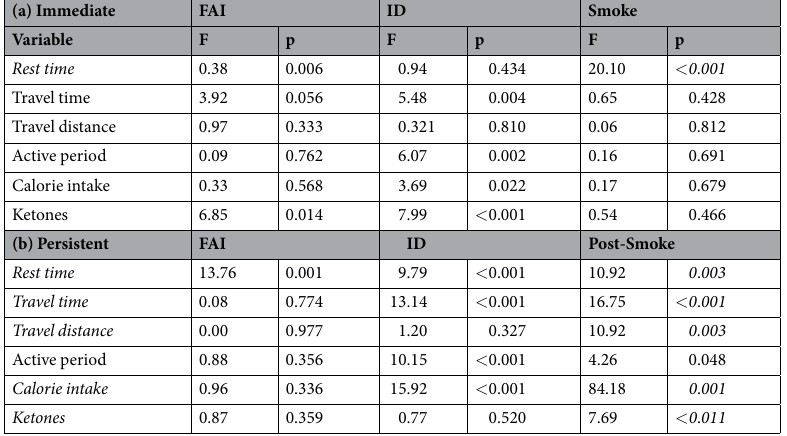
Table 1. LMM results for (a) immediate (smoke) and (b) persistent (post-smoke) changes in activity and energetics; italics = significant after Hochberg